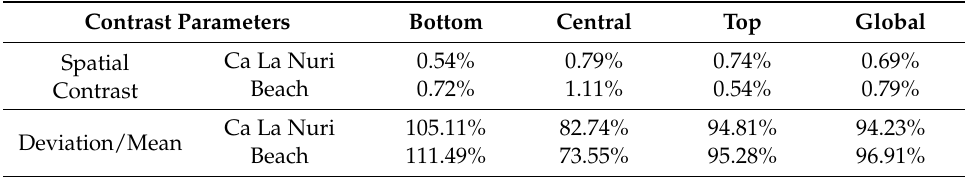
Table 4. Spatial contrast of the second workplane (the face) of each restaurant. The results are shown as